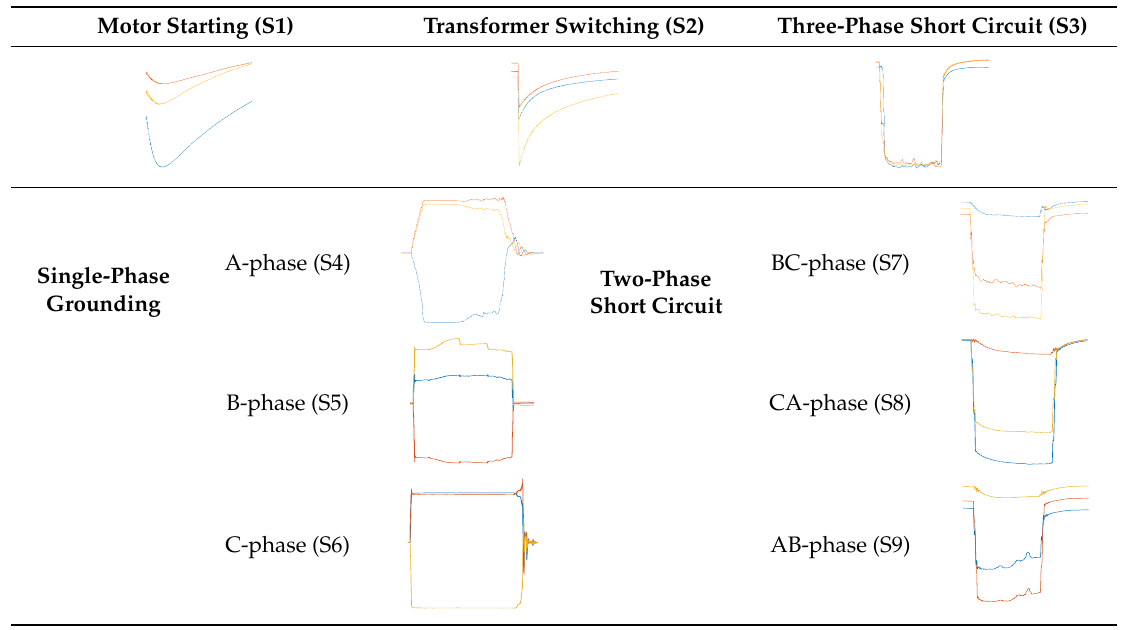
Table 1. Standard sample for voltage sag category.